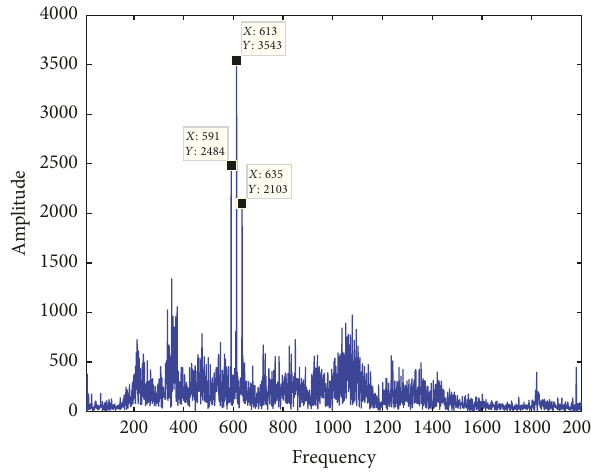
Figure 19: The LCT of the selected signal segment presented in Figure